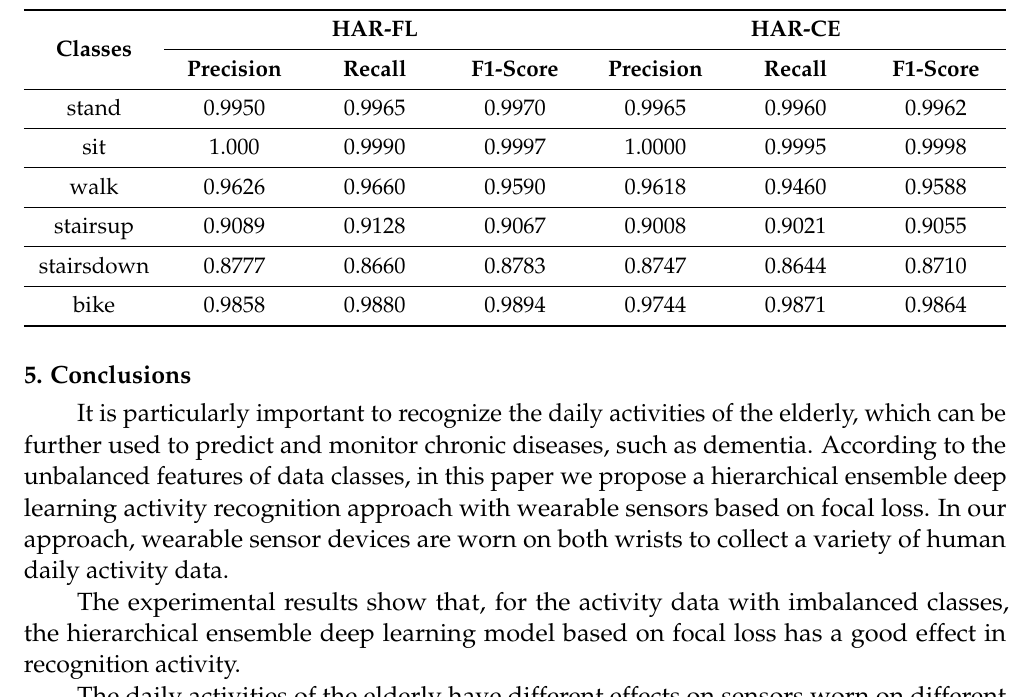
Table 11. The distribution of indicators for each class of HAR-FL and HAR-CE with D H